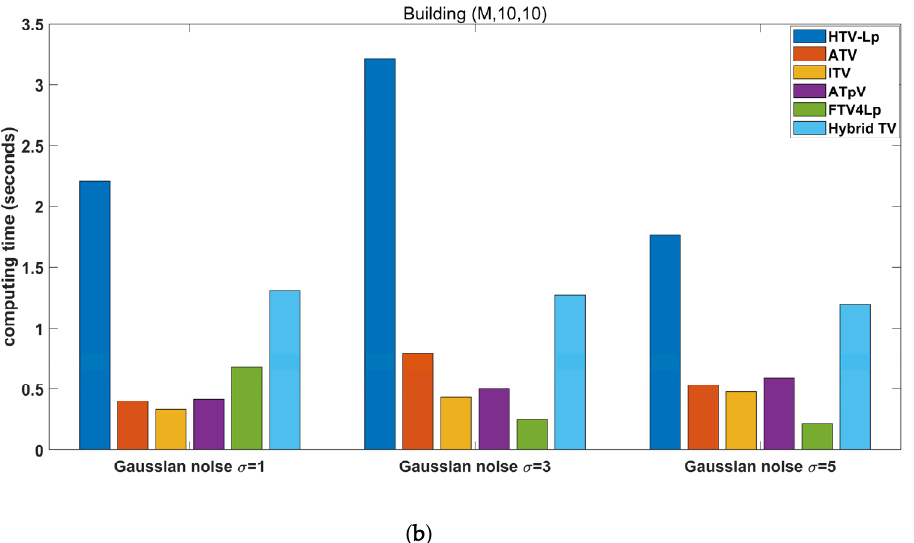
Figure 8. Comparison of computing times of di ff erent deblurring methods. ( a ) degraded “Building” image with Gaussian blur (G, 5, 5, 7) and ( b ) degraded “Building” image with motion blur (M, 10, 10).